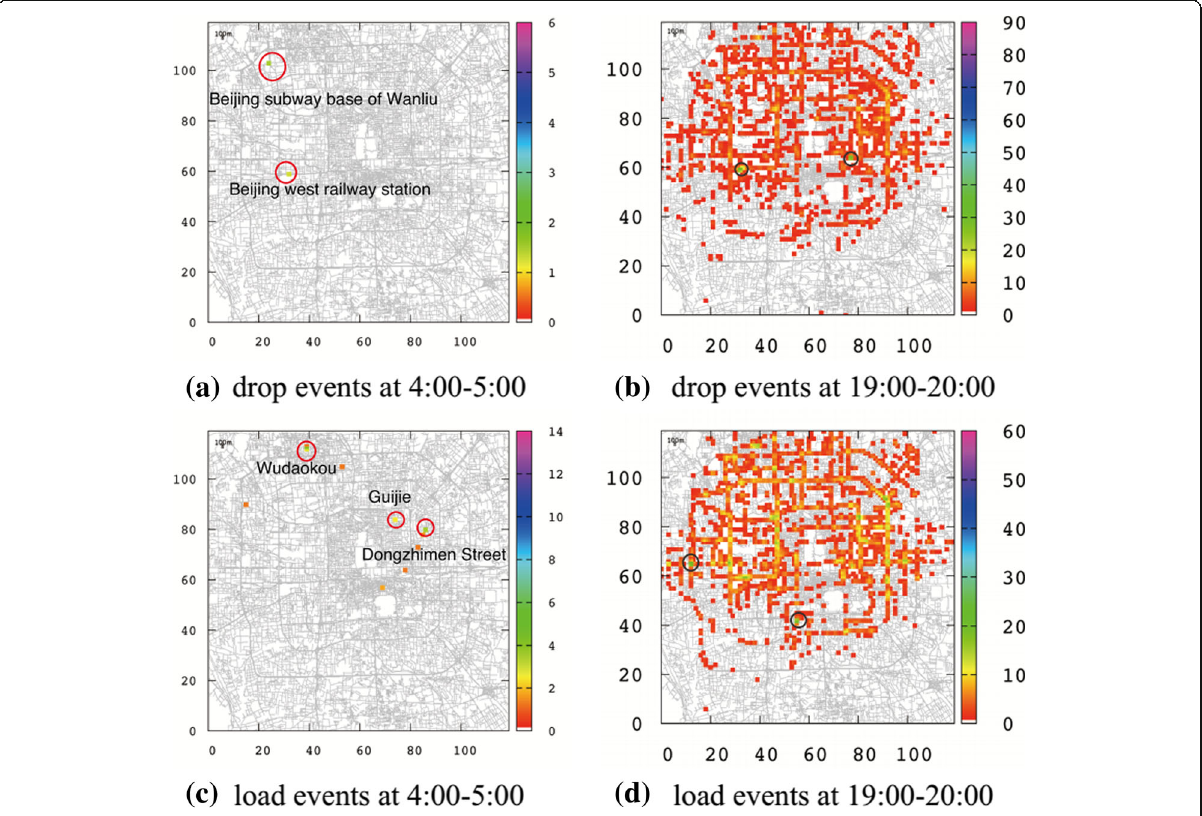
Fig. 6 Drop and load events in a city. Based on analyzing drop and load incidents, accurate hotspots of drop and load event happens for taxi can be finally obtained as shown in this figure, ( a ) and ( b ) show the drop events recognition results at 4:00-5:00 and 19:00-20:00, ( c ) and ( d ) show load events results at 4:00-5:00 and